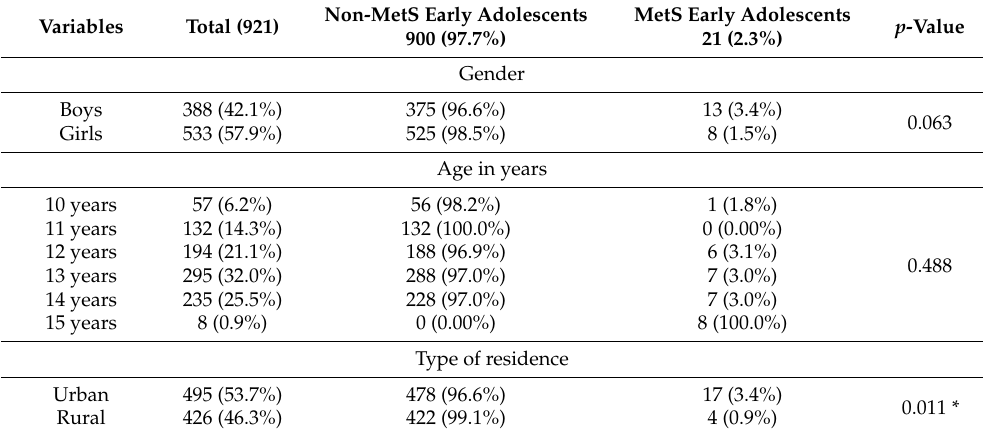
Table 2. Association between prevalence of metabolic syndrome and demographic